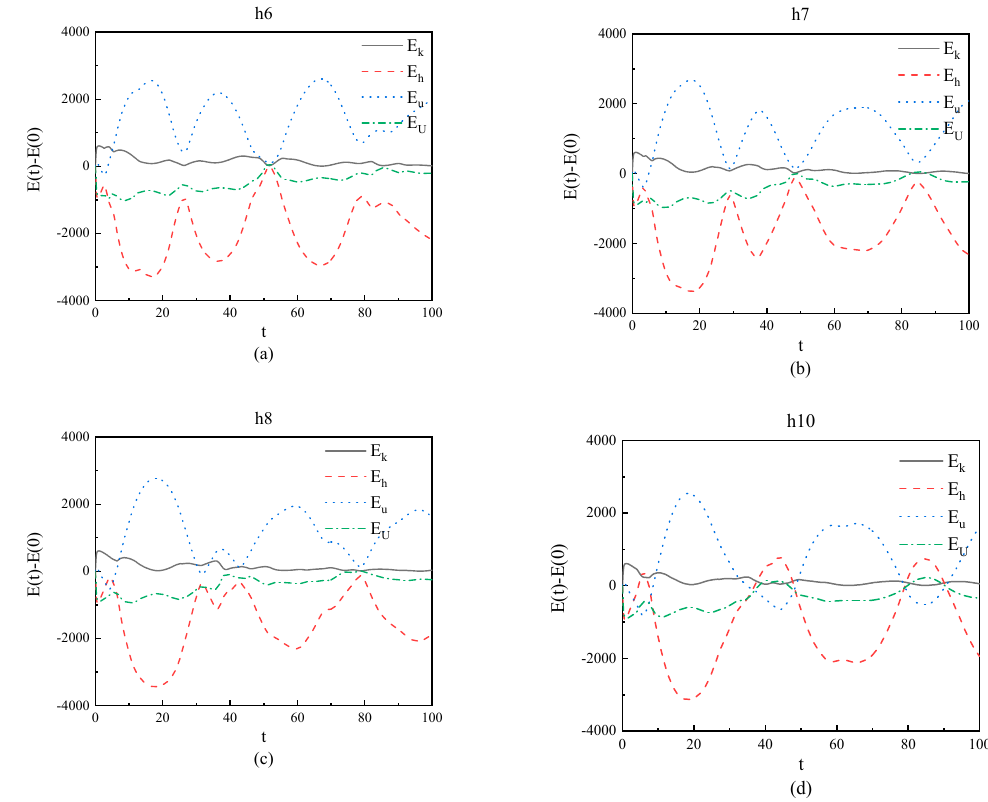
Figure 13. ( a – d ) Energy conversion and entropy increase with time for Cases h6 to h10.